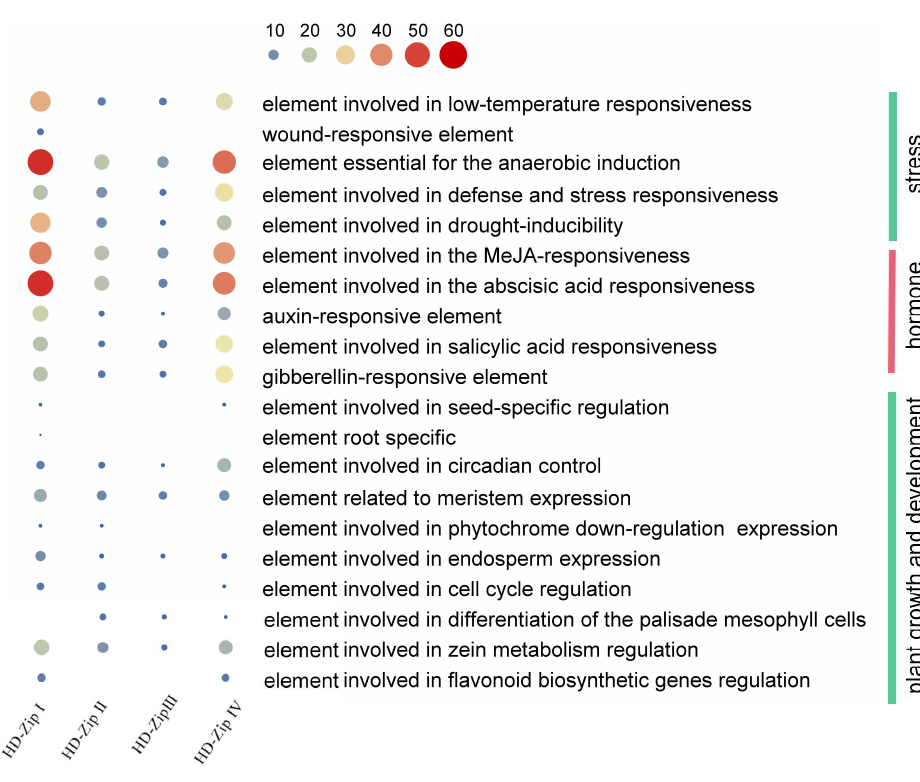
Figure 4. Overview of the number of BnHD-Zip genes with the main cis-acting elements on promoters in four